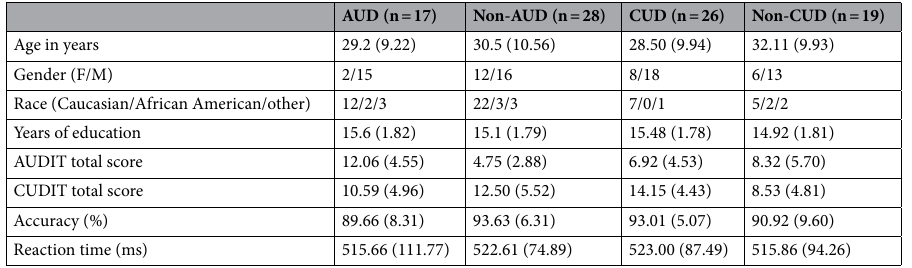
Table 1. Participant demographics by comparison. Means (standard deviation) for each group. The full sample is represented in the AUD comparison as well as the CUD